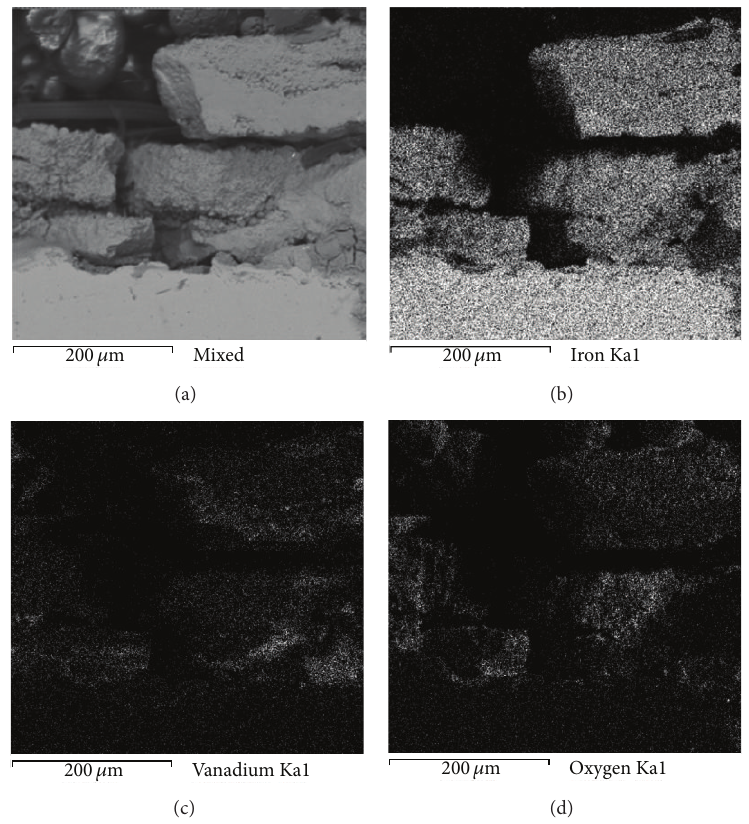
Figure 4: Cross-sectional aspect of Fe and elements distribution after corrosion